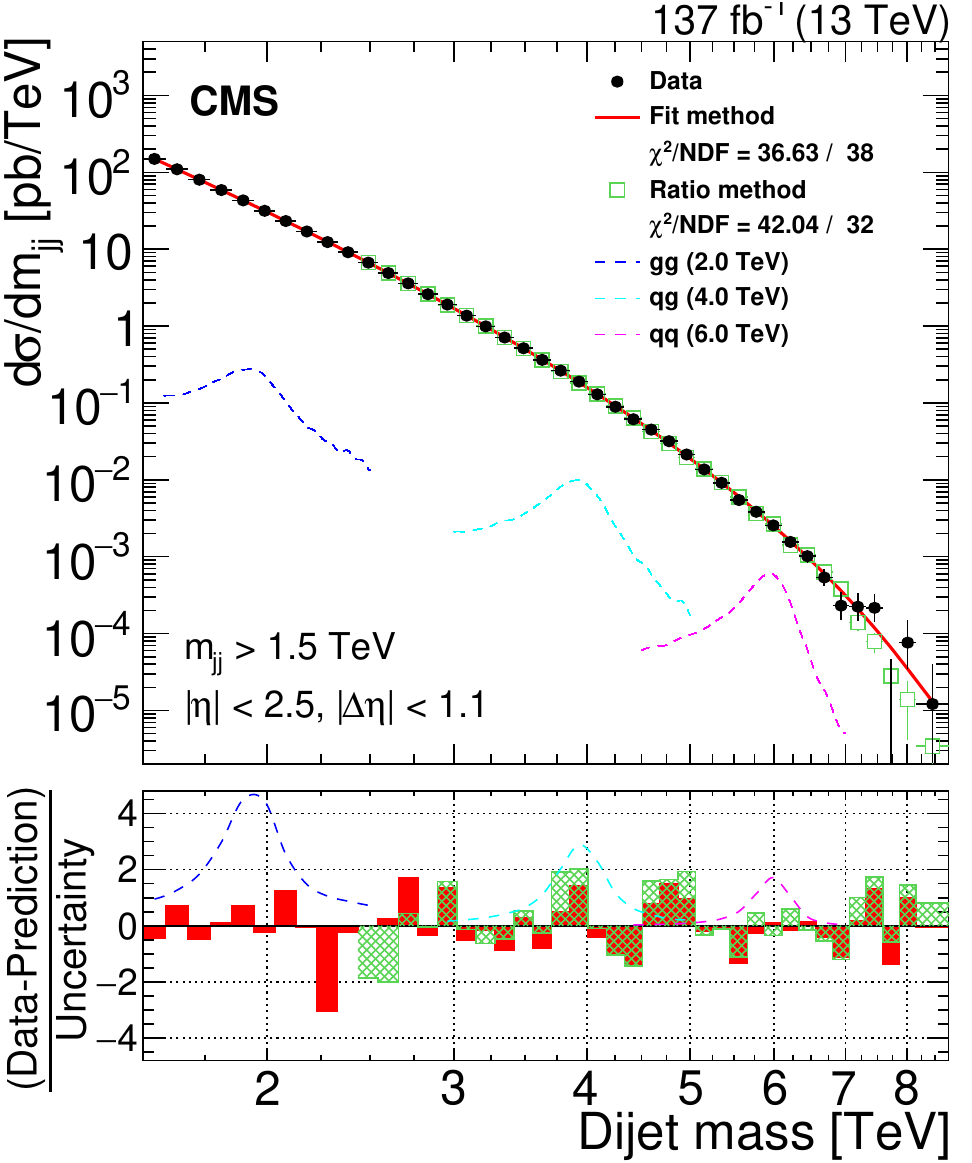
Figure 5 . Dijet mass spectrum in the signal region (points) compared to a (cid:12)tted parameterization of the background (solid line) and the one obtained from the control region (green squares). The lower panel shows the di(cid:11)erence between the data and the (cid:12)tted parametrization (red, solid), and the data and the prediction obtained from the control region (green, hatched), divided by the statistical uncertainty in the data, which for the ratio method includes the statistical uncertainty in the data in the control region. Examples of predicted signals from narrow gluon-gluon, quark- gluon, and quark-quark resonances are shown (dashed coloured lines) with cross sections equal to the observed upper limits at 95% CL.